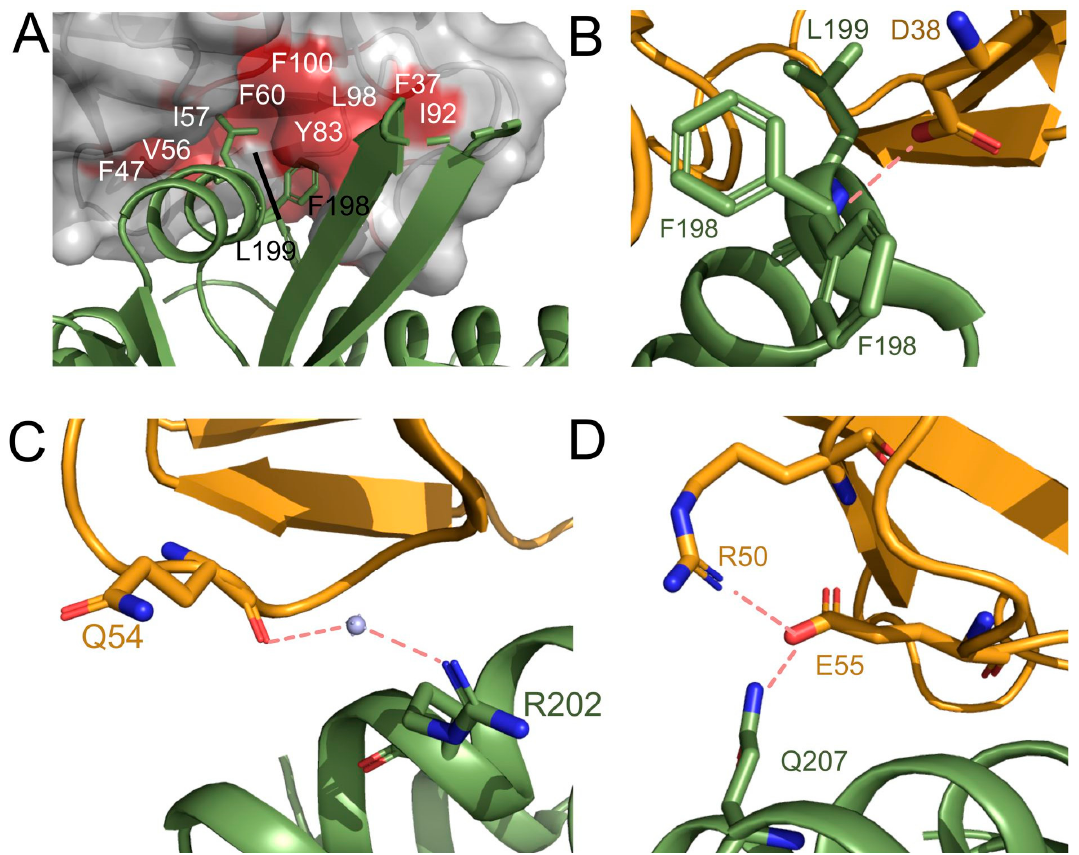
Figure 3. Interactions between ALK2 and FKBP12.6. ( A ) α GS2 residues ALK2 Phe198 and Leu199 (green) inserted into a hydrophobic pocket in FKBP12.6 (grey surface with hydrophobic patch shown in red). ( B ) Backbone hydrogen bond from ALK2 Leu199 to the side chain of FKBP12.6 Asp38. ( C ) Water-mediated hydrogen bond between ALK2 Arg202 and FKBP12.6 Gln54. ( D ) Hydrogen bonding between ALK2 Gln207 and FKBP12.6 Glu55 and Arg50.